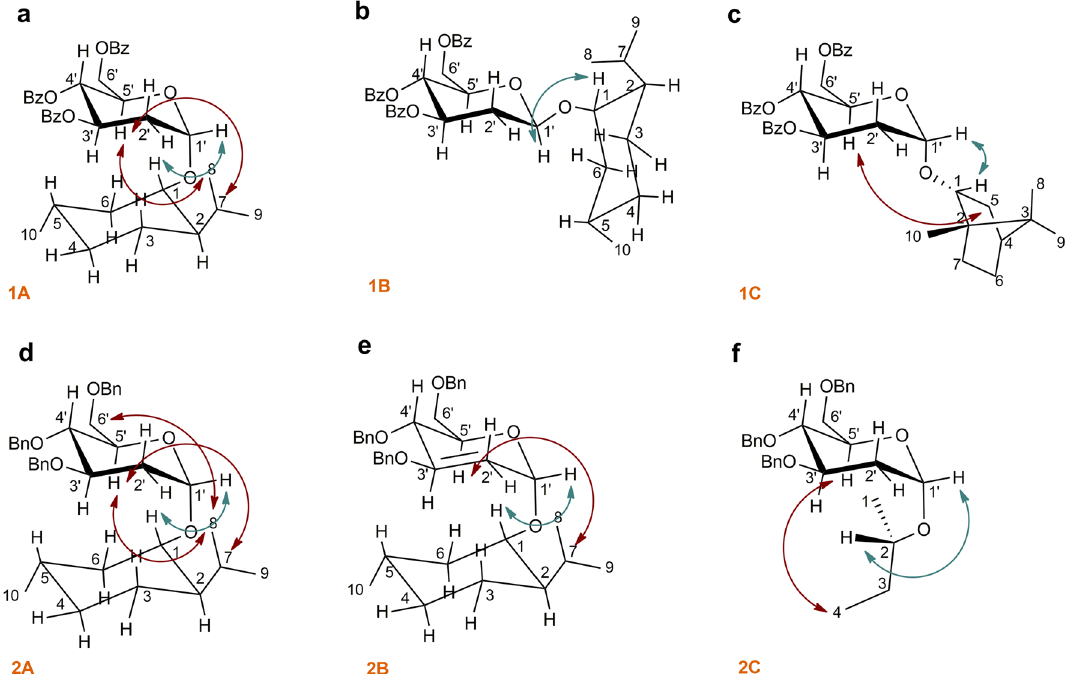
Figure 6. Determination of S*/R* the absolute configuration of 1A , 1B , 1C , 2A , 2B and 2C . The diagnostic ROEs are depicted as bidirectional arrows (blue—first diagnostic signal 1’H / 1H of 1A—2C ; red—second